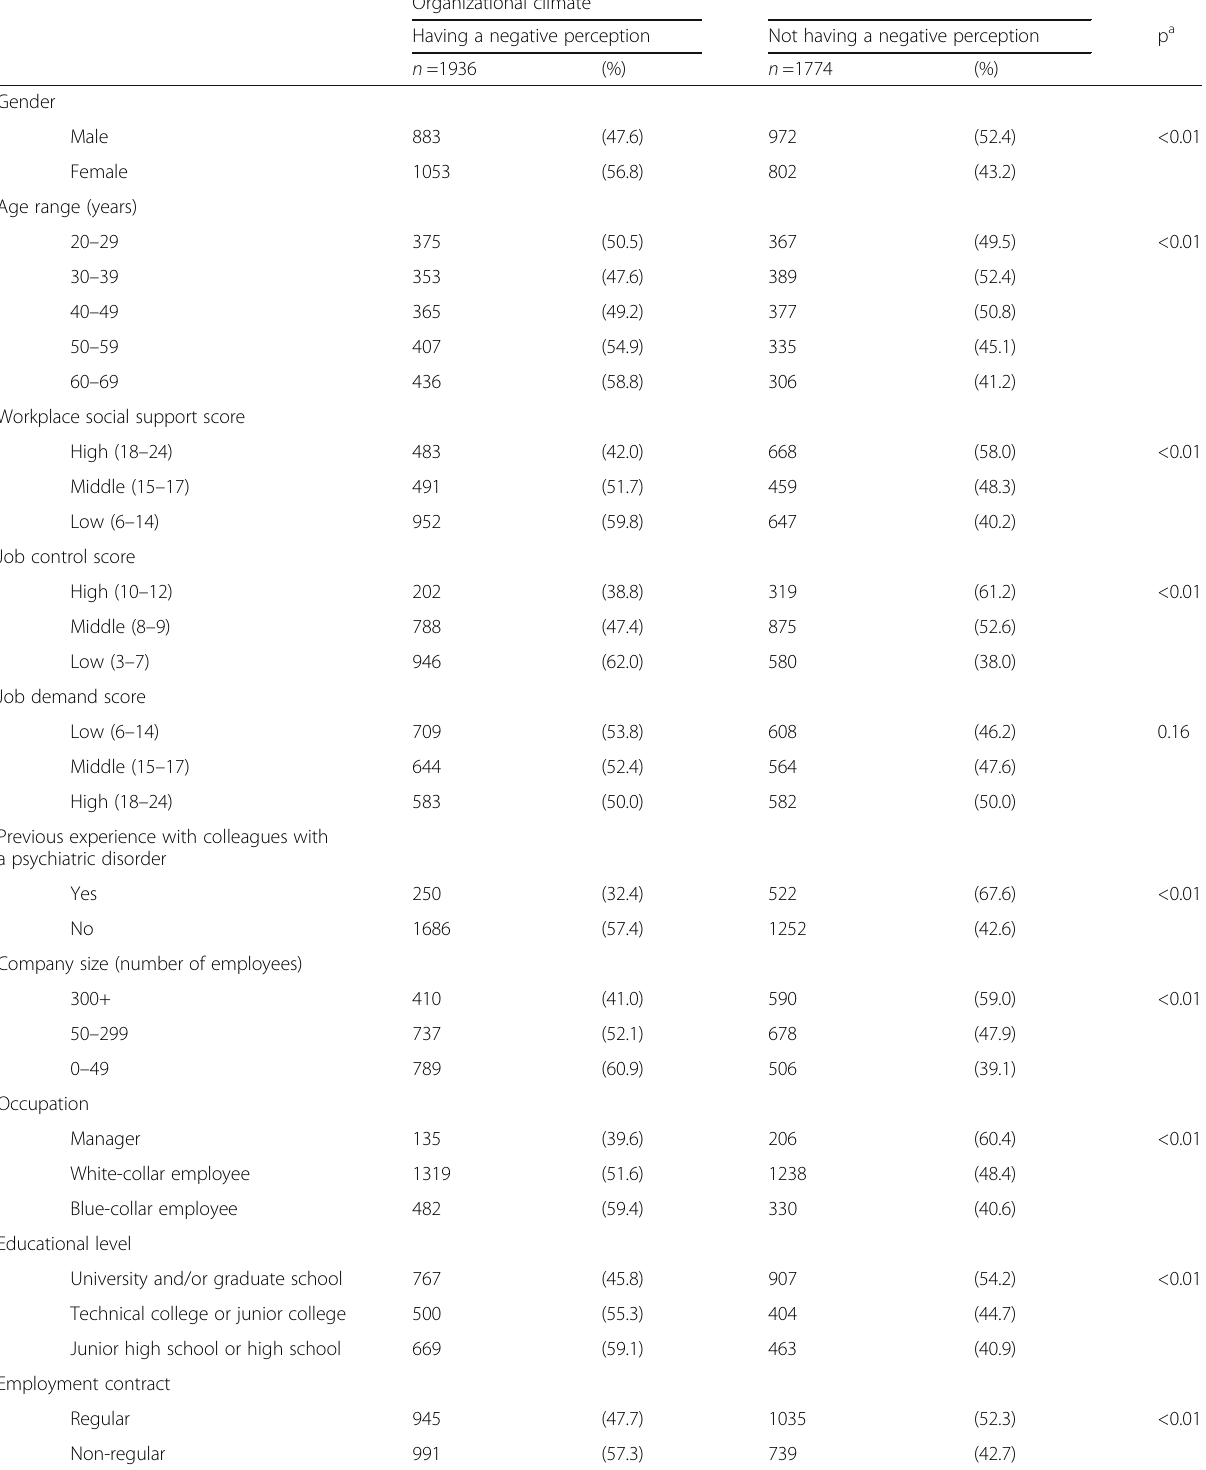
Table 2 Associations between psychosocial and socioeconomic factors and colleagues ’ negative perception ( n =3,710) Organizational climate Having a negative perception Not having a negative